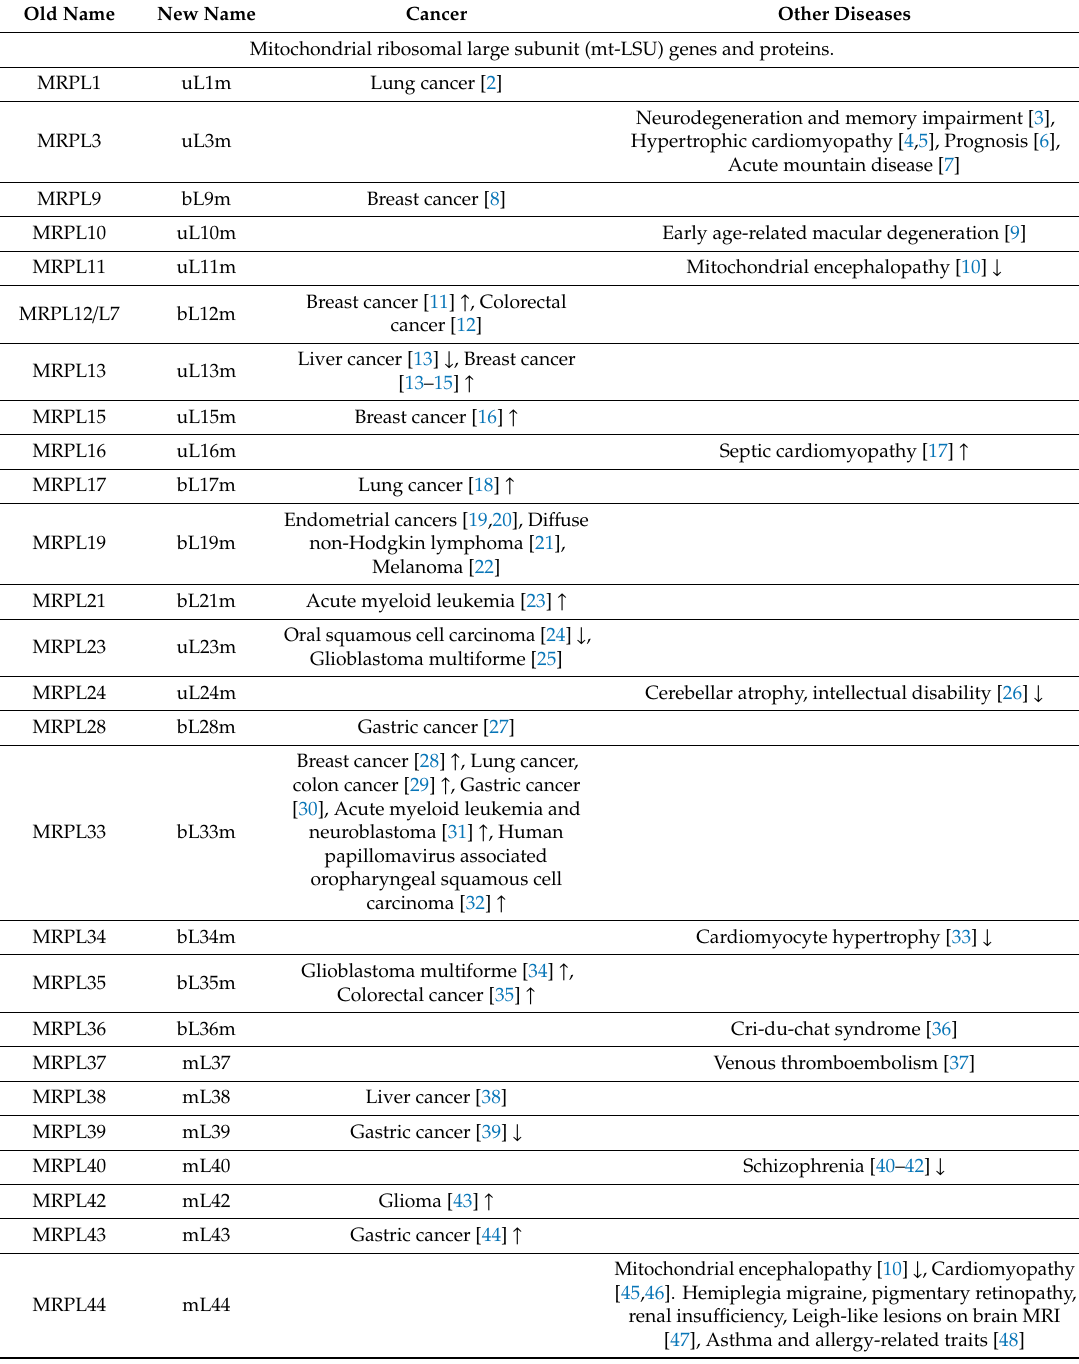
Table 1. Summary of the relationship between abnormal expression of mitochondrial ribosomal proteins and their encoding genes with diseases in recent 5